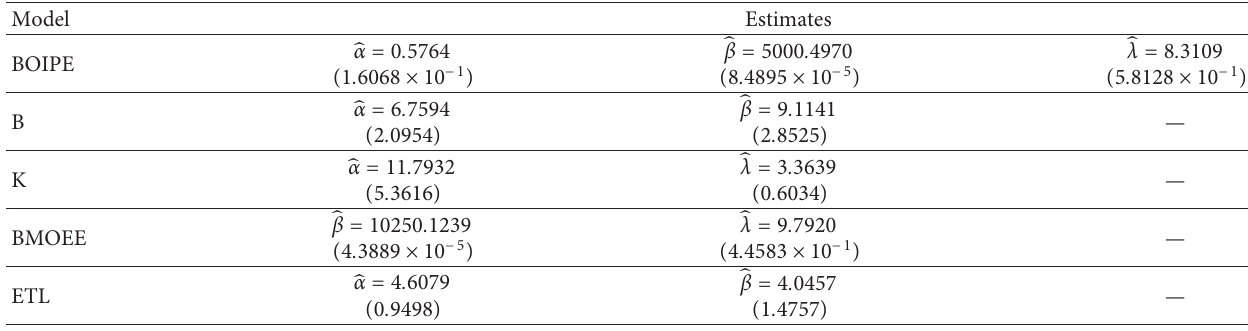
Table 6: Maximum likelihood estimates for data